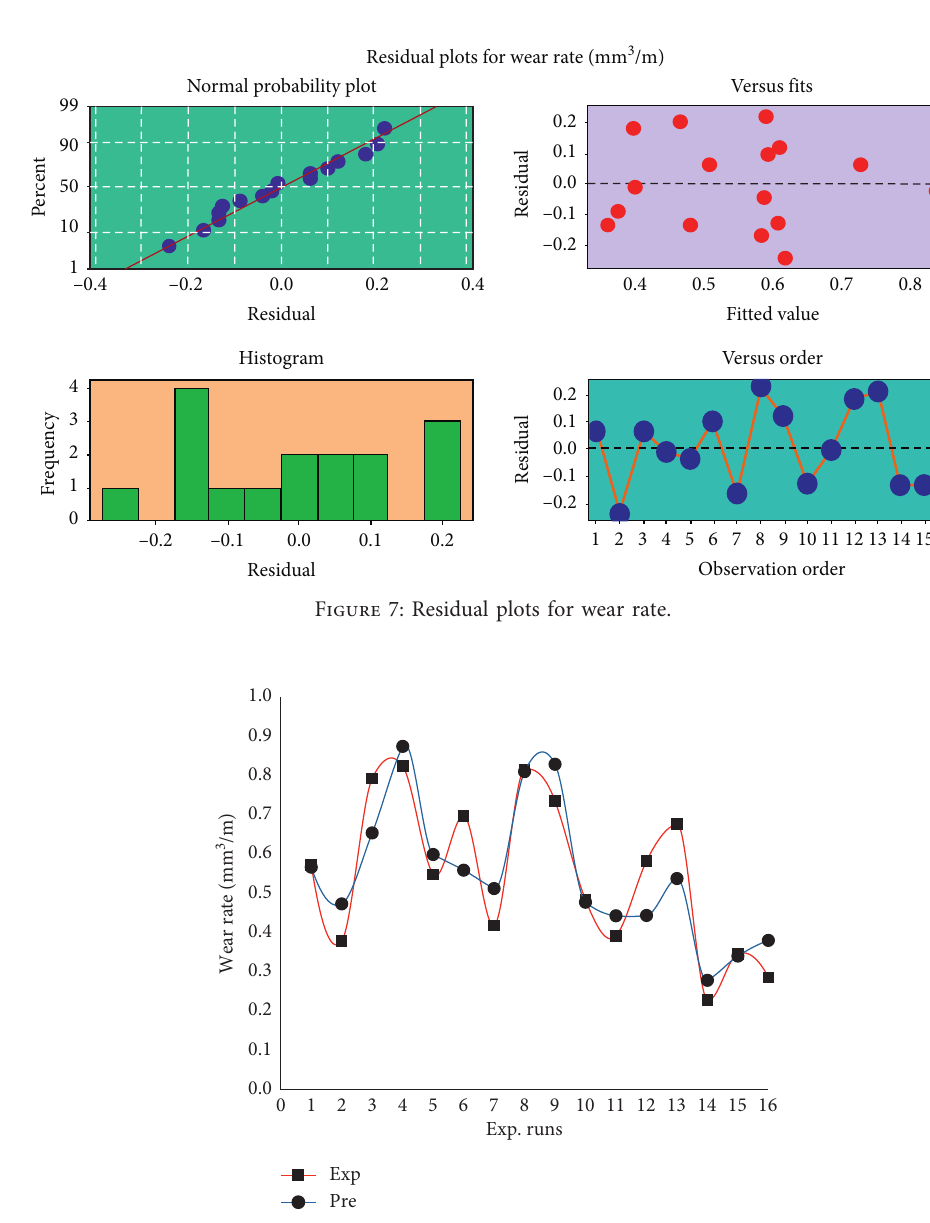
Figure 8: Experimental runs versus wear